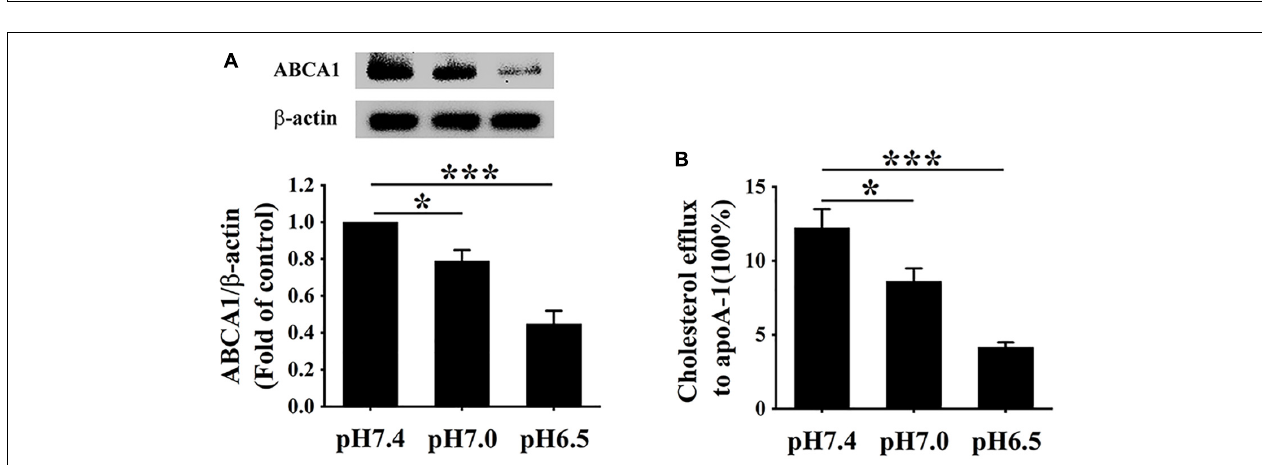
FIGURE 3 | Extracellular acidification enhances calpain1 expression via activating ASIC1 in macrophages. (A) RAW 264.7 cells were incubated in different pH media with ox-LDL for 24 h, and then the expression of calpain1 was determined using WB analysis. (B) RAW 264.7 macrophages were incubated in pH 6.5 medium containing 25 µ g/ml ox-LDL with amiloride (0, 50, and 100 µ M) for 24 h. Calpain1 expression was determined using WB analysis. Data were shown as the mean ± SEM from 3 to 4 independent experiments. Statistical analysis was performed by one-way ANOVA. ** P < 0.01; *** P < 0.001.